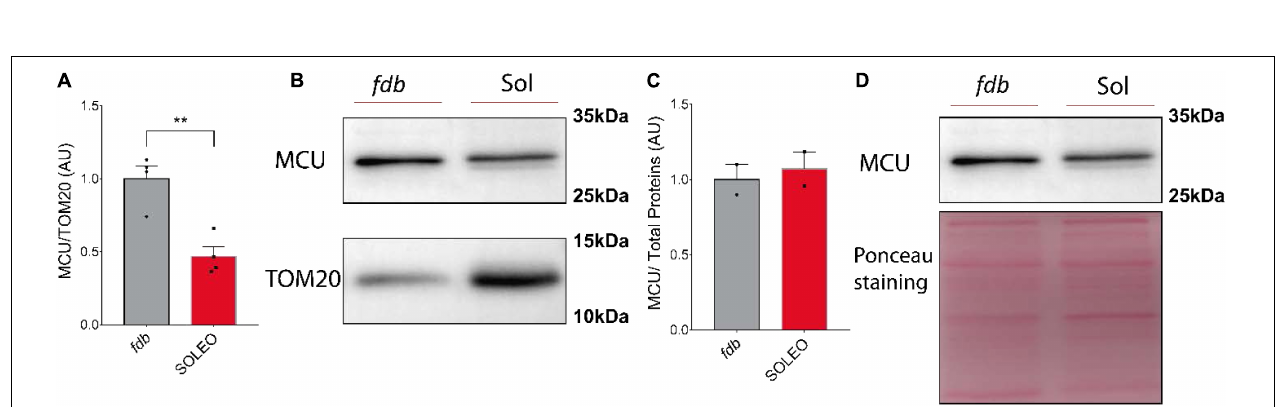
Frontiers in Physiology |